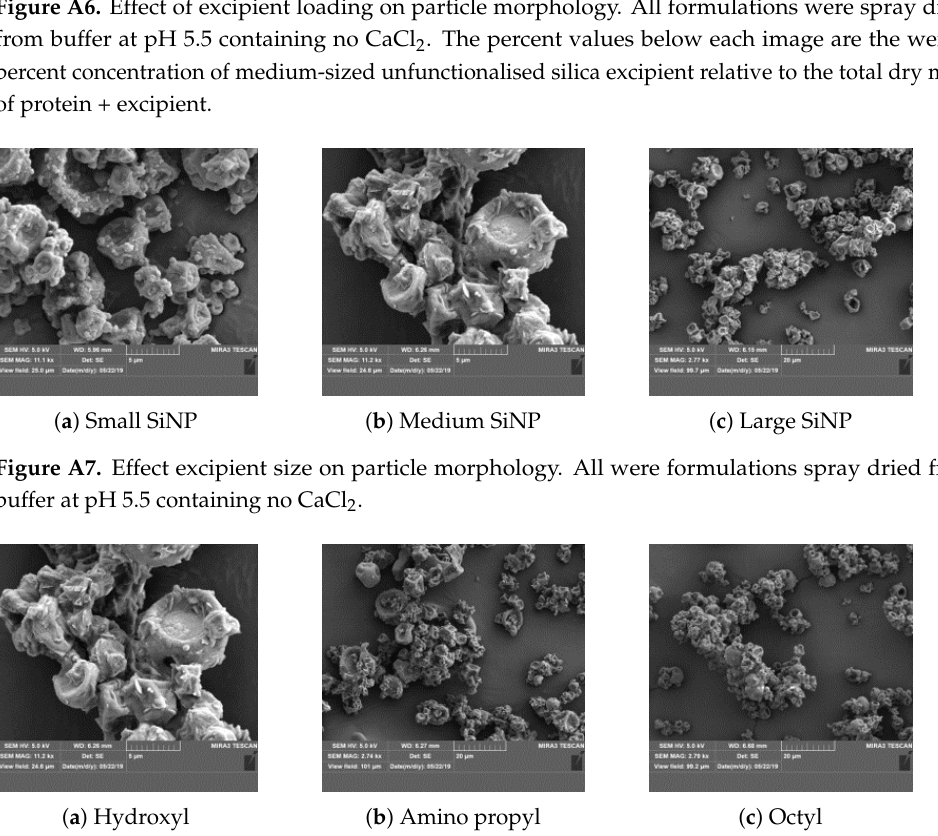
Figure A8. Effect of excipient surface functionalisation on particle morphology. All formulations spray dried from buffer at pH 5.5 containing no CaCl 2 . Medium sized SiNP were used in all cases (D h , water = 38 ± 1 nm). Note that scale of images ( a , b ) differs from that of ( c